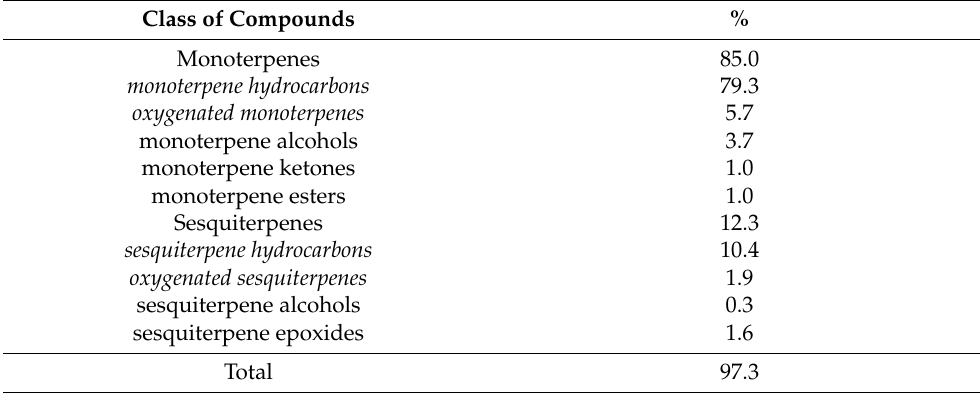
Table 2. The volatiles presented in percentage for each class of